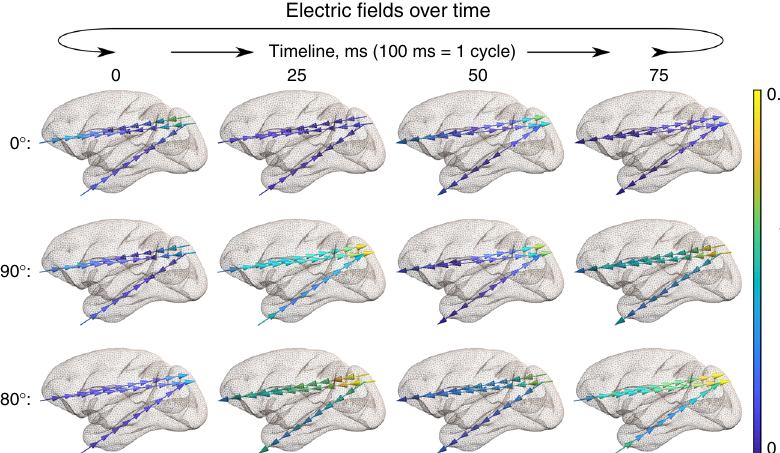
Fig. 5 Electric fi elds in the brain over time during TES for a given stimulation condition. The panel depicts the main conditions (0°, 90°, and 180° stimulation phase differences) for subject 1. Arrows indicate the electric fi eld direction, and the color encodes the electric fi eld magnitude. See Supplementary Fig. 9 for subject 2 and Supplementary Movies 2 and 3 for more details